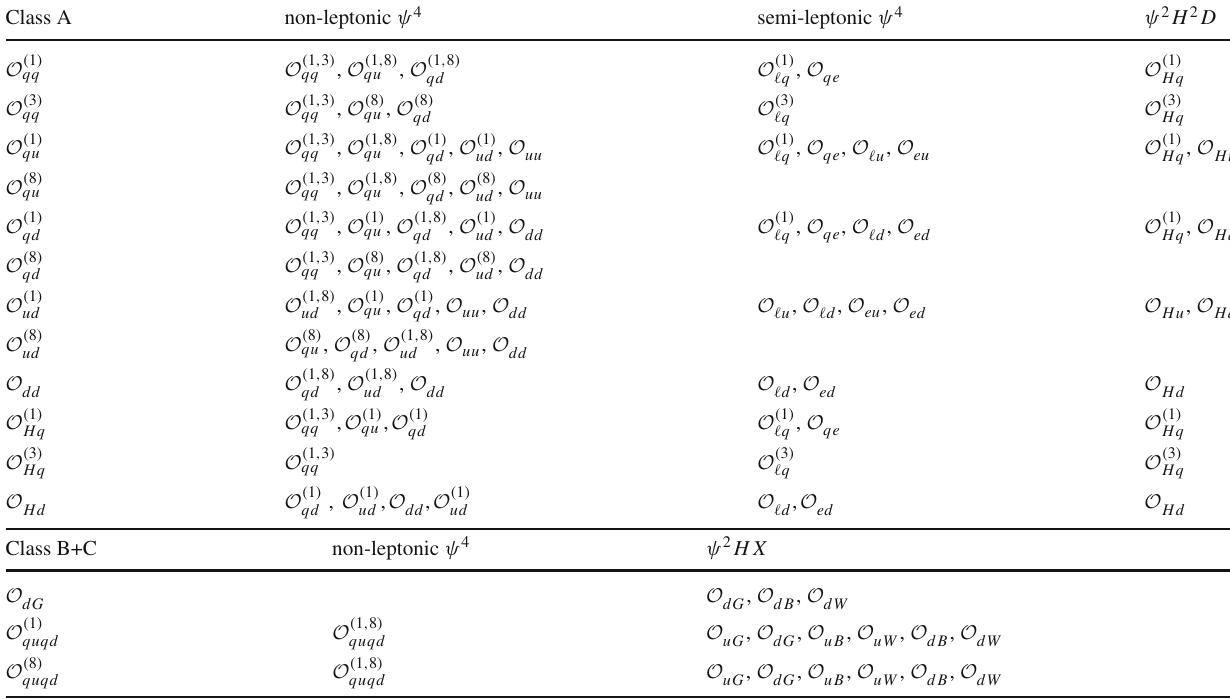
Table 14 List of SMEFT operators that mix in SMEFT at one-loop with the ones in Classes A–C through gauge couplings. Self-mixing is included. We have omitted O (Class E) that only mixes with itself through gauge couplings Hud Class